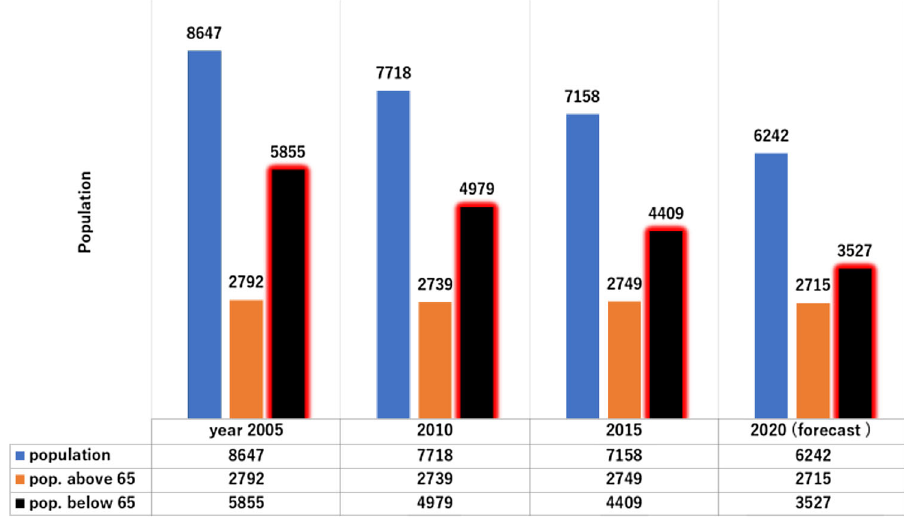
Fig. 4 Population change